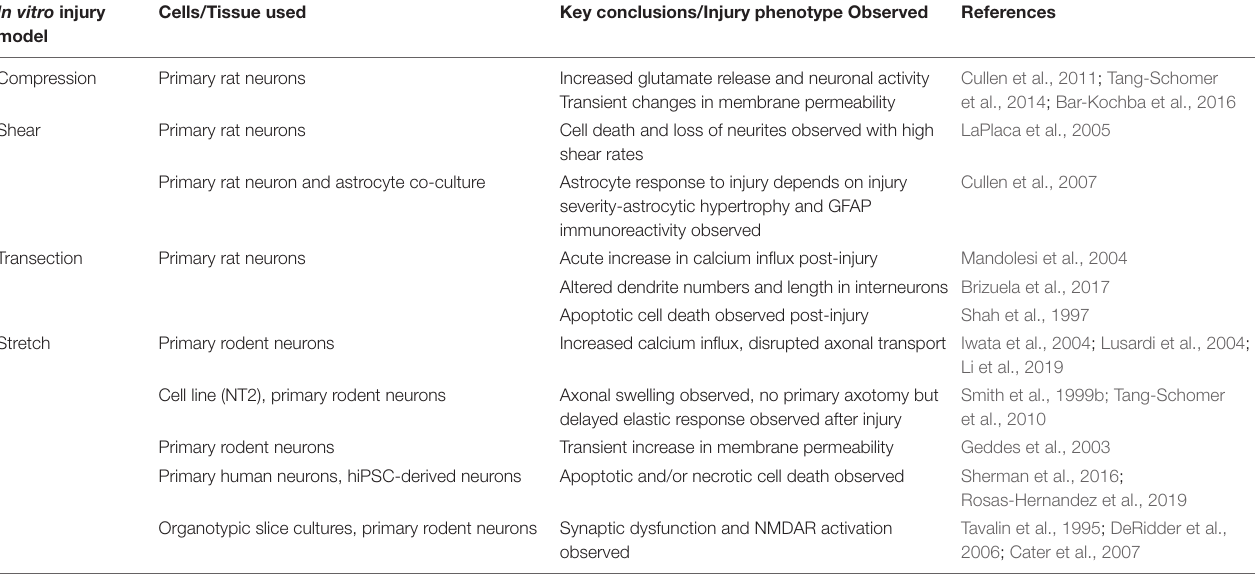
TABLE 2 | Summary of in vitro injury model studies with key injury phenotypes observed in these models